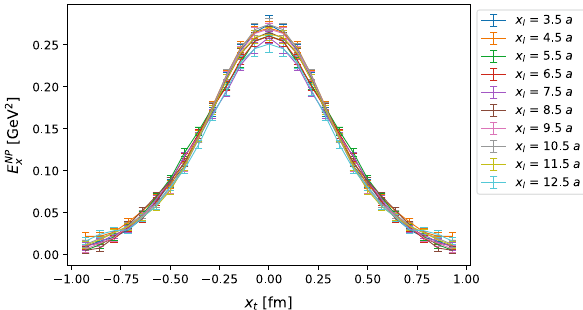
Fig. 5 Transverse cross sections of the nonperturbative field E NP x ( x t ) at β = 6 . 240, d = 1 . 142 fm, for several values of x